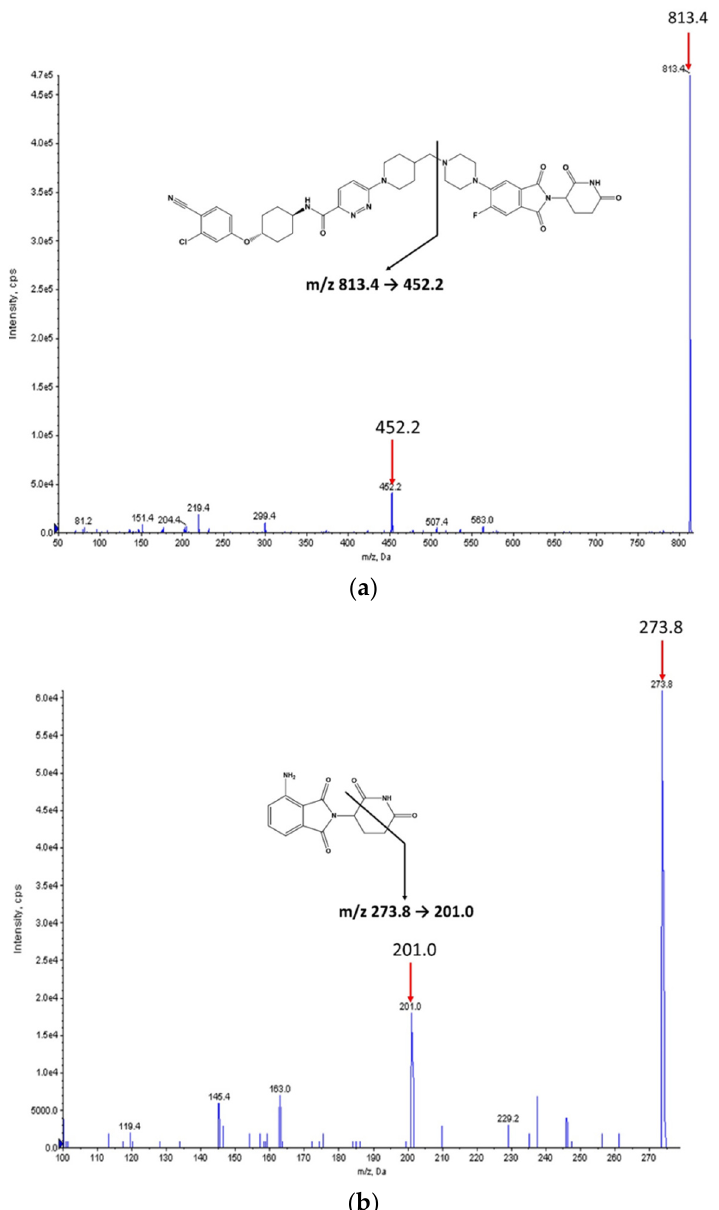
Figure 1. Representative product ion spectra of ARV-110 ( a ); and pomalidomide ( b ) in positive ionization mode.